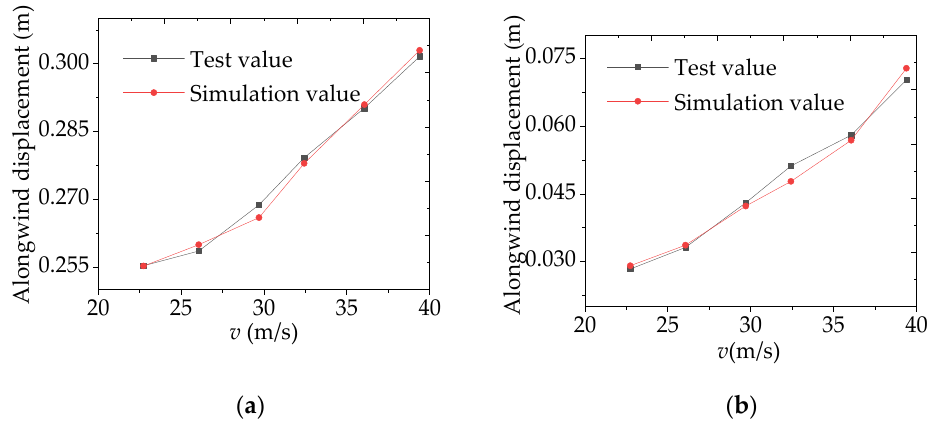
Figure 7. Comparison between test and simulation value of wind-induced vibration displacements: ( a ) Mean value, ( b ) Standard deviation.